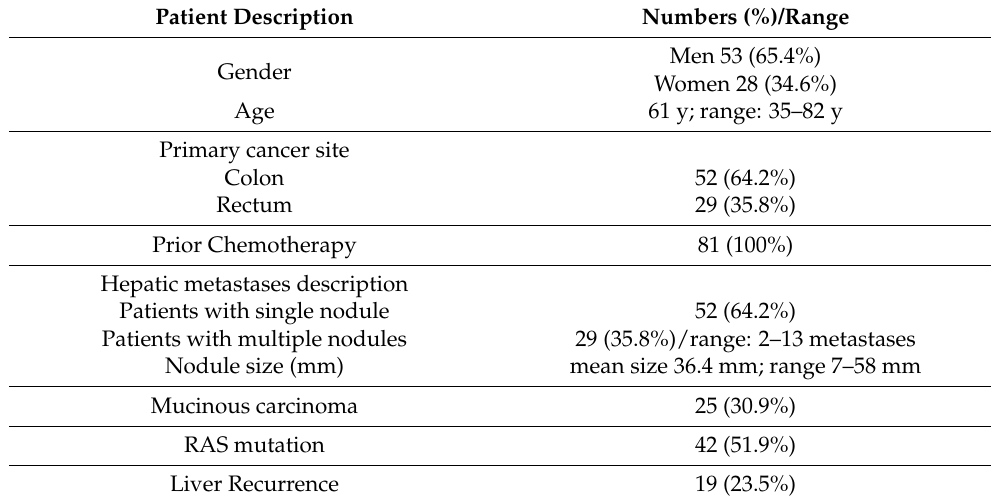
Table 1. Characteristics of the study population (81 patients).